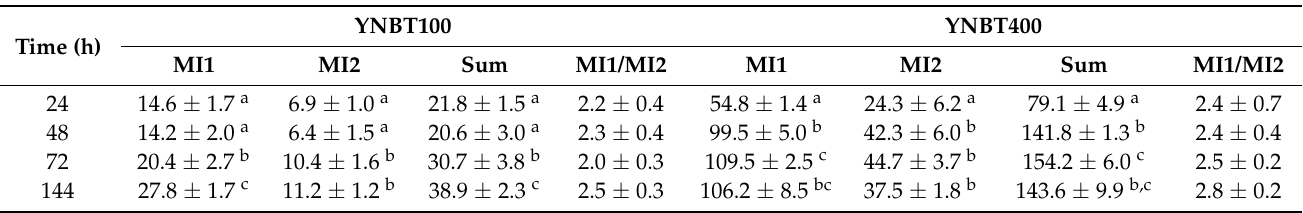
Figure 3. Melatonin isomers (MI) production by S.cerevisiae EC1118. Chromatogram in ( A ) shows the melatonin transition ( m/z 233.2 > 174.2) of a pure standard containing melatonin (MEL, rt 6.80) tryptophan ethyl ester (TEE, rt 6.11) both at a concentration of 2 ng/mL and internal standard (MEL OCD3, rt 6.84, m/z 236.2 > 177.2, black). Chromatograms in ( B ) show the superimposition of melatonin trace ( m/z 233.2 > 174.2) from three different S. cerevisiae EC1118 fermentation supernatants at 24 h (blue), 48 h (red), and 72 h (green). In ( B ) is evident the absence of the melatonin peak that should be expected at the same retention time of its labeled analogue (rt 6.80, black). Among melatonin isomers in fermentation medium it was evidenced the presence of tryptophan ethyl ester (TEE, rt 6.06) and two isomers, named MI1 (rt 4.70) and MI2 (rt 5.6), with a not-elucidated structure. Table 1. MI1 and MI2 productions. Letters indicate different significant values ( p < 0.05) at the yeast growth phases (24, 48, 72, and 144 h). Concentrations of MIs and their sums are here expressed in µ g/L, considering the melatonin response. Letters indicate the grouping information using the Fisher LSD Method and 95%